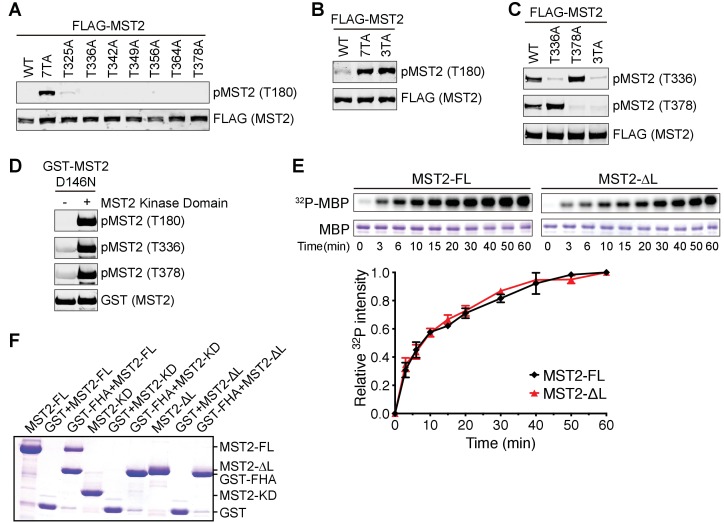
Feedback inhibition of MST2 activation by SLMAP binding to autophosphorylated MST2 linker.(A and B) Anti-FLAG and anti-pMST2 (T180) blots of lysates of 293FT cells transfected with the indicated FLAG-MST2 plasmids. (C) Anti-FLAG, anti-pMST2 (T336), and anti-pMST2 (T378) blots of lysates of 293FT cells transfected with the indicated FLAG-MST2 plasmids. (D) In vitro kinase assay of MST2 kinase domain using GST-MST2 D146N as the substrate. Immunoblots of the kinase reaction mixtures were shown. Anti-GST blot was used to evaluate protein levels. (E) The in vitro kinase assays of MST2-FL and MST2-∆L using myelin basic protein (MBP) as substrate. The reaction mixtures were separated on SDS-PAGE and analyzed by a phosphoimager (top) and Coomassie blue staining (middle). FL, full-length; ΔL, linker deletion. The kinetic profiles of MBP phosphorylation by activated MST2 FL and ∆L as monitored by 32P incorporation (bottom). The relative 32P-MBP signal intensities, normalized to those of MST2 FL and ∆L at 60 min (100%), respectively, are plotted against time. Means ± range for two independent experiments are plotted. (F) Coomassie-stained gel of the indicated MST2 proteins bound to GST-SLMAP FHA (residues 1–140) beads. FL, full-length; KD, kinase domain; ΔL, linker deletion.